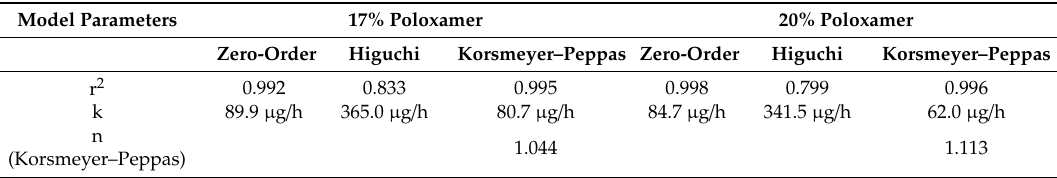
Table 1. Goodness of fit for each poloxamer system after fitting drug release data to three kinetic models commonly used to study drug release from poloxamer